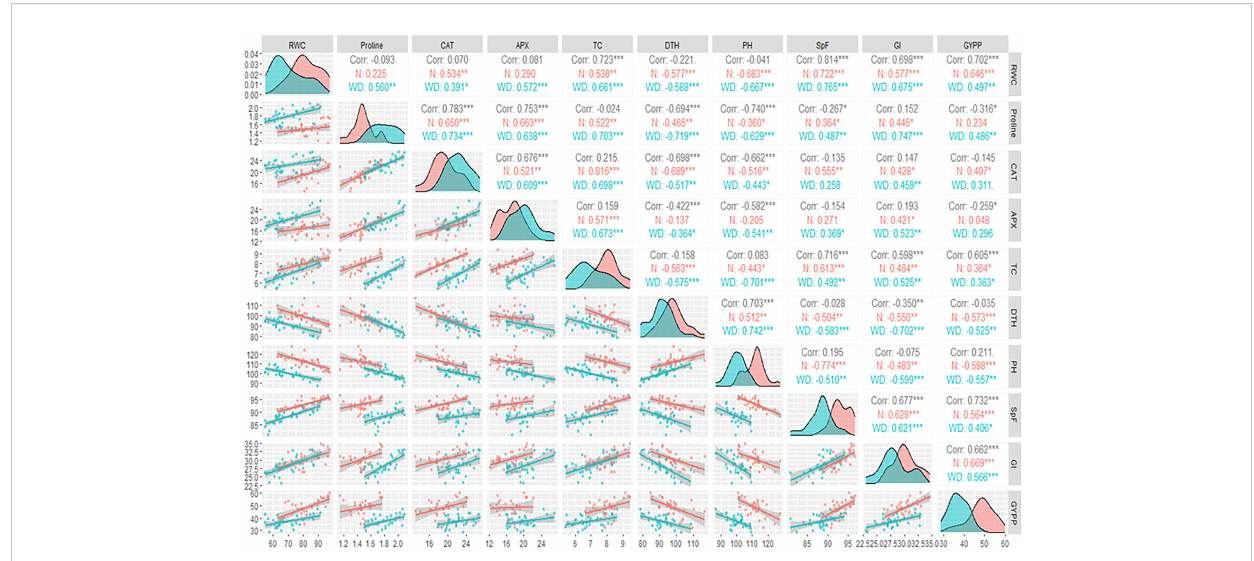
FIGURE 2 Pearson correlation matrix among the studied traits under normal and water de fi cit conditions.*, ** and *** indicate p< 0.05, p<0.01 and